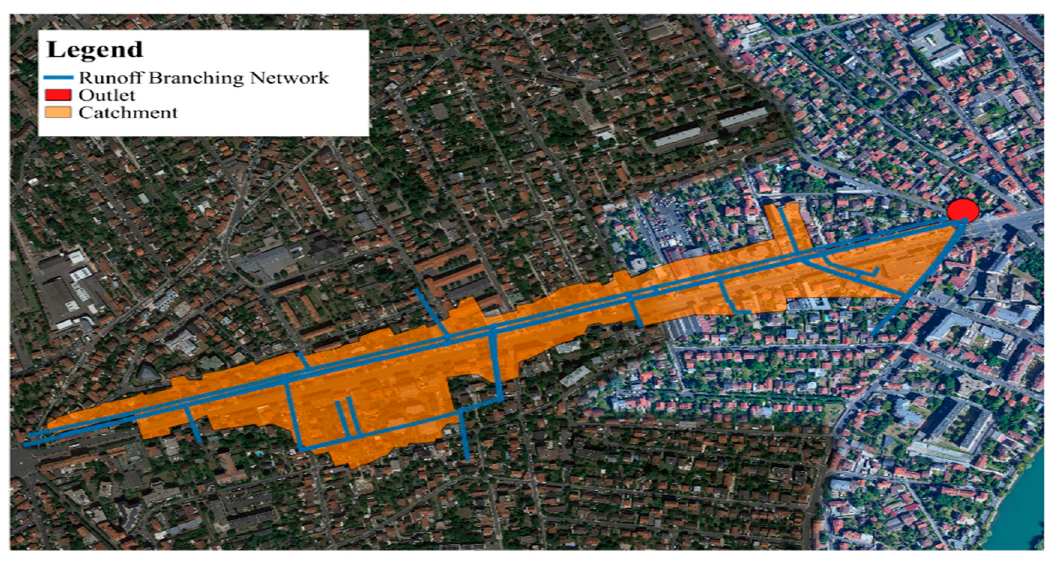
Figure 3. The studied catchment and the runoff branching network (including both street and sewer segments). The red point represents the outlet of the catchment.